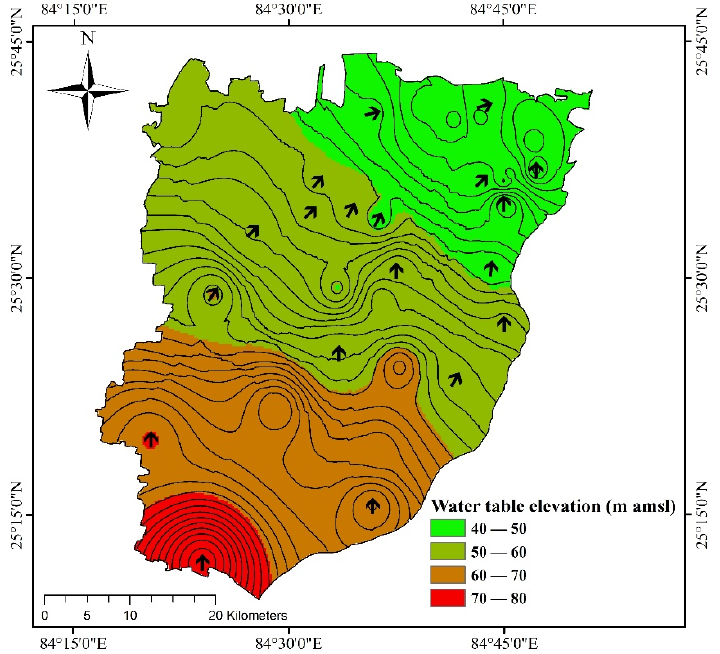
Figure 4. Water table elevation and groundwater flow direction in the study area.